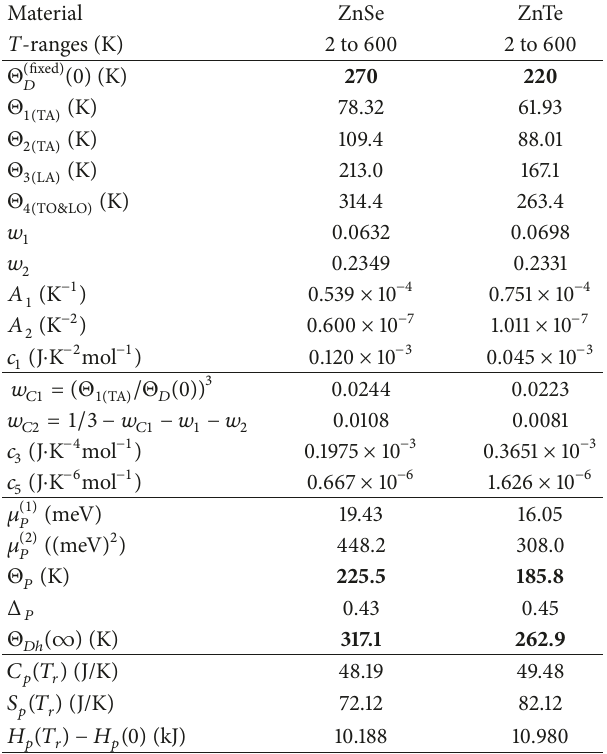
Table 1: Sets of the adjusted model-specific parameter values, which have been obtained (for properly fixed Θ 𝐷 (0) values) via combined least-mean-square fittings of the presently considered sets of low- and high-temperature isobaric heat capacity data, 𝐶 𝑝 (𝑇) , for ZnSe (Figure 2) and for ZnTe (Figure 3), using (5) in combination with (9) and (14) to (17). In the lower part of Table 1 we have still quoted a series of characteristic, material-specific quantities (cf. the text), the actual values of which are resulting in unambiguous way from the fitted parameter values listed previously.